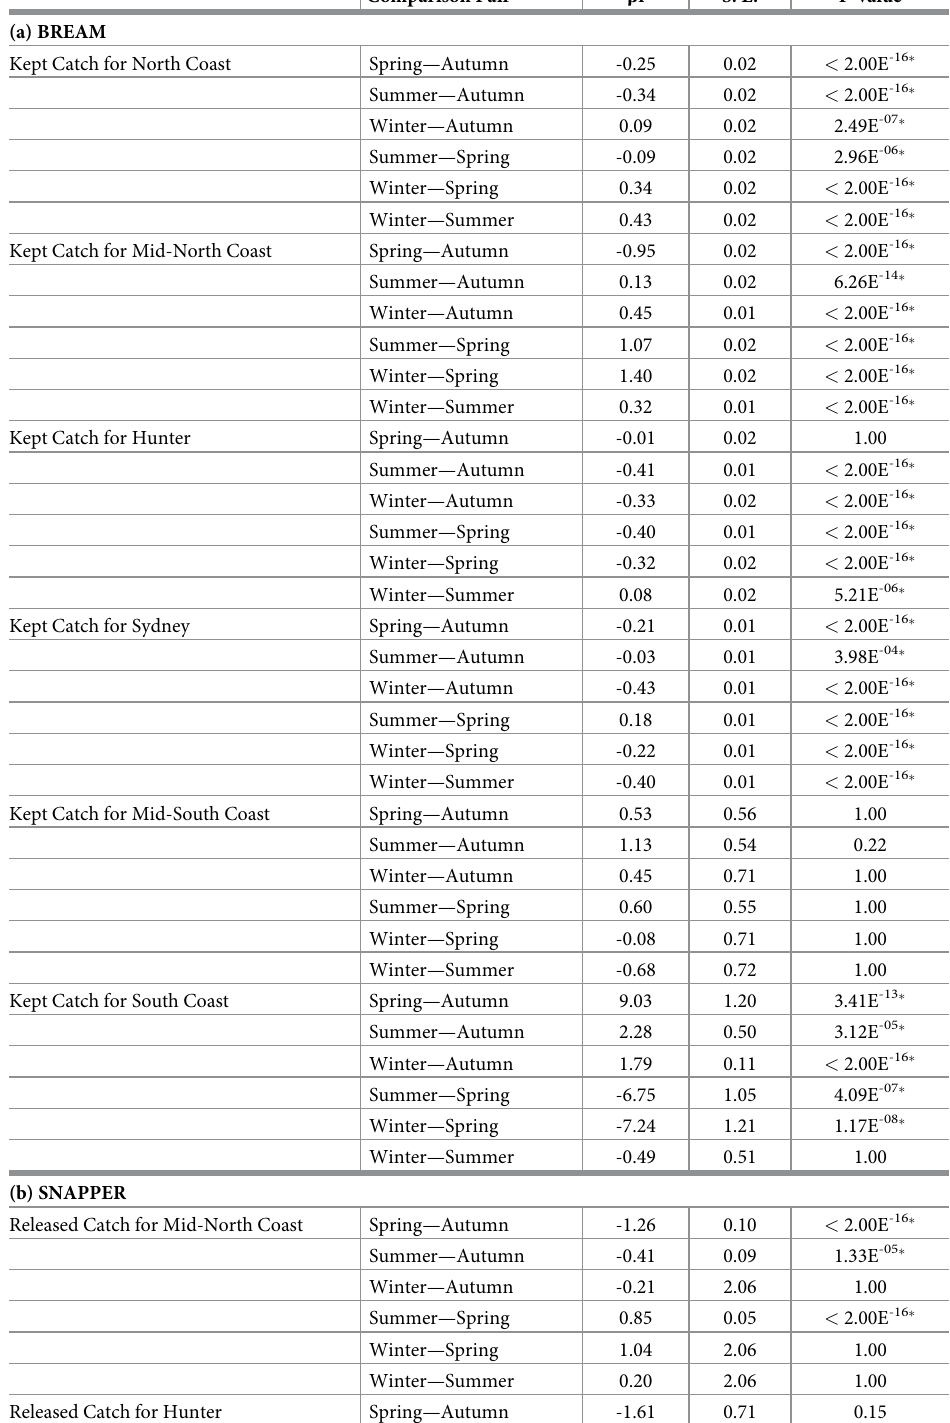
Table 3. The results of the Tukey’s post-Hoc test ( α = 0.05) comparing different levels of season (4 levels: Autumn, Spring, Summer, Winter) in terms of the number of estuary-caught a) bream that were kept and b) snapper